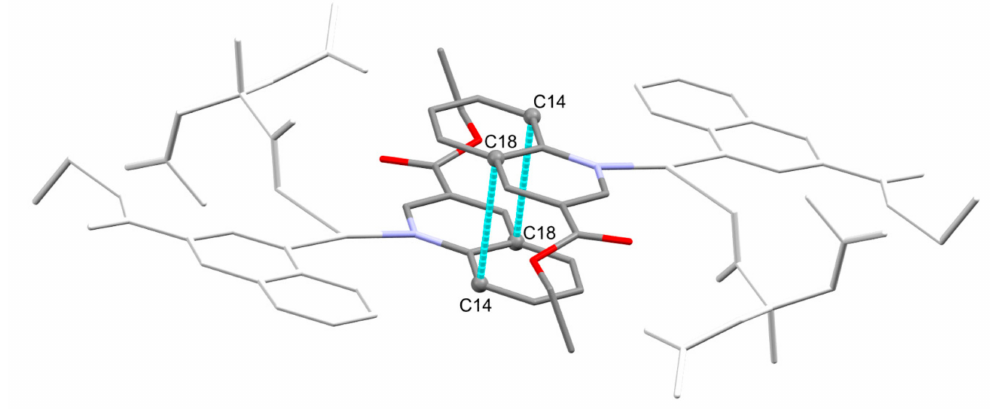
Figure 4. The π – π stacking interactions in the [Ag(Et3qu) 2 (citrate)] complex.